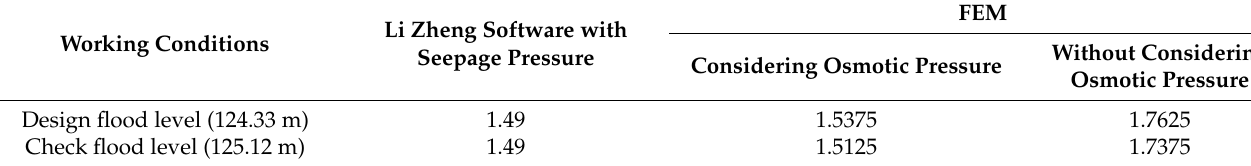
Figure 13. The Maximum shear strain diagrams. Table 4. Contrast Table of safety factor F .